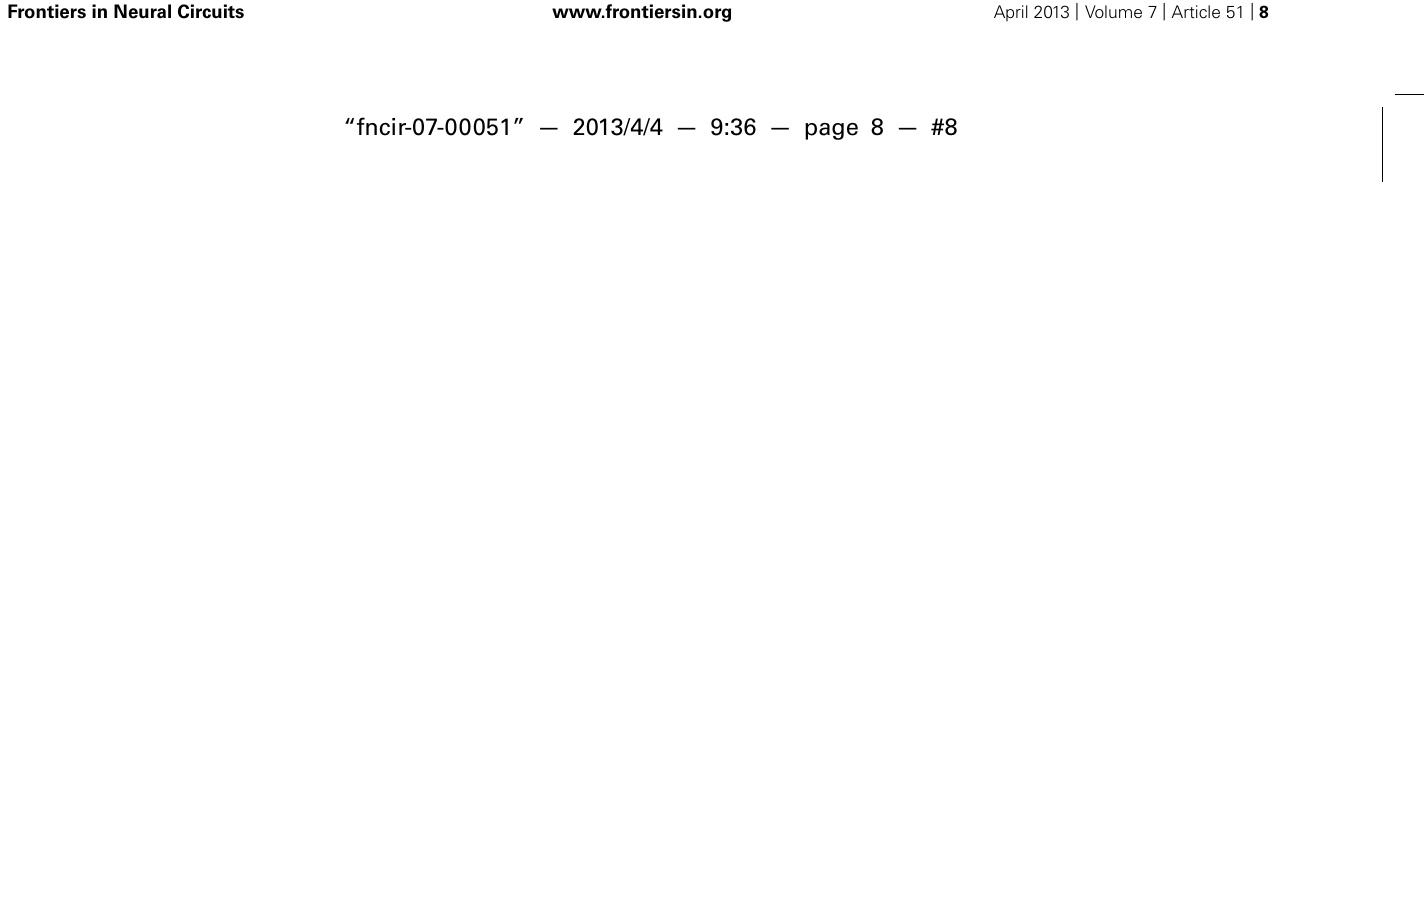
the actual neural firing dropped below 2 spikes/s from 150 to 250 ms after the target jump. Unlike the “Summed” prediction, the “Replaced” prediction (gray dashed) successfully predicted this transient drop in firing rate for the double-step condition. The R 2 between the actual and predicted double-step PETH was 0.80 for the “Replaced” hypothesis, but 0.05 for the “Summed”